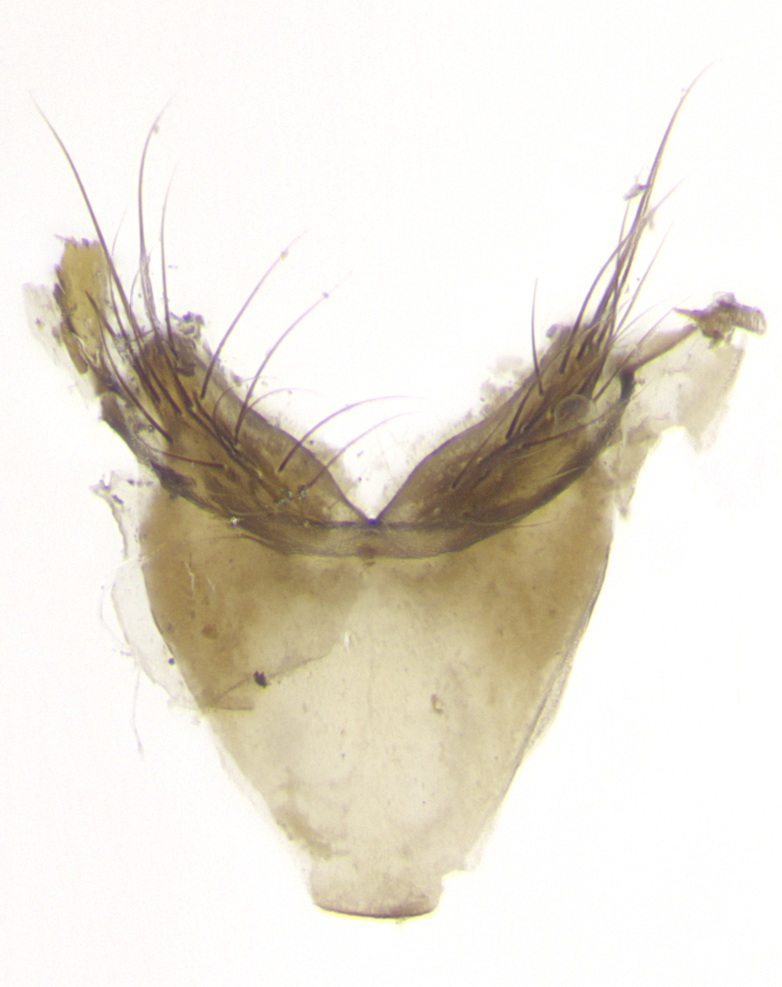
sternite 5, ventral view.